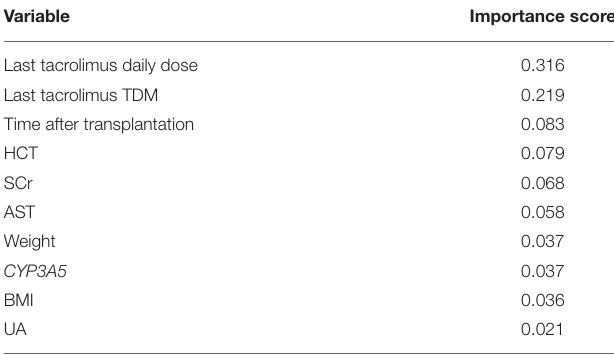
TABLE 5 | Ranking of importance